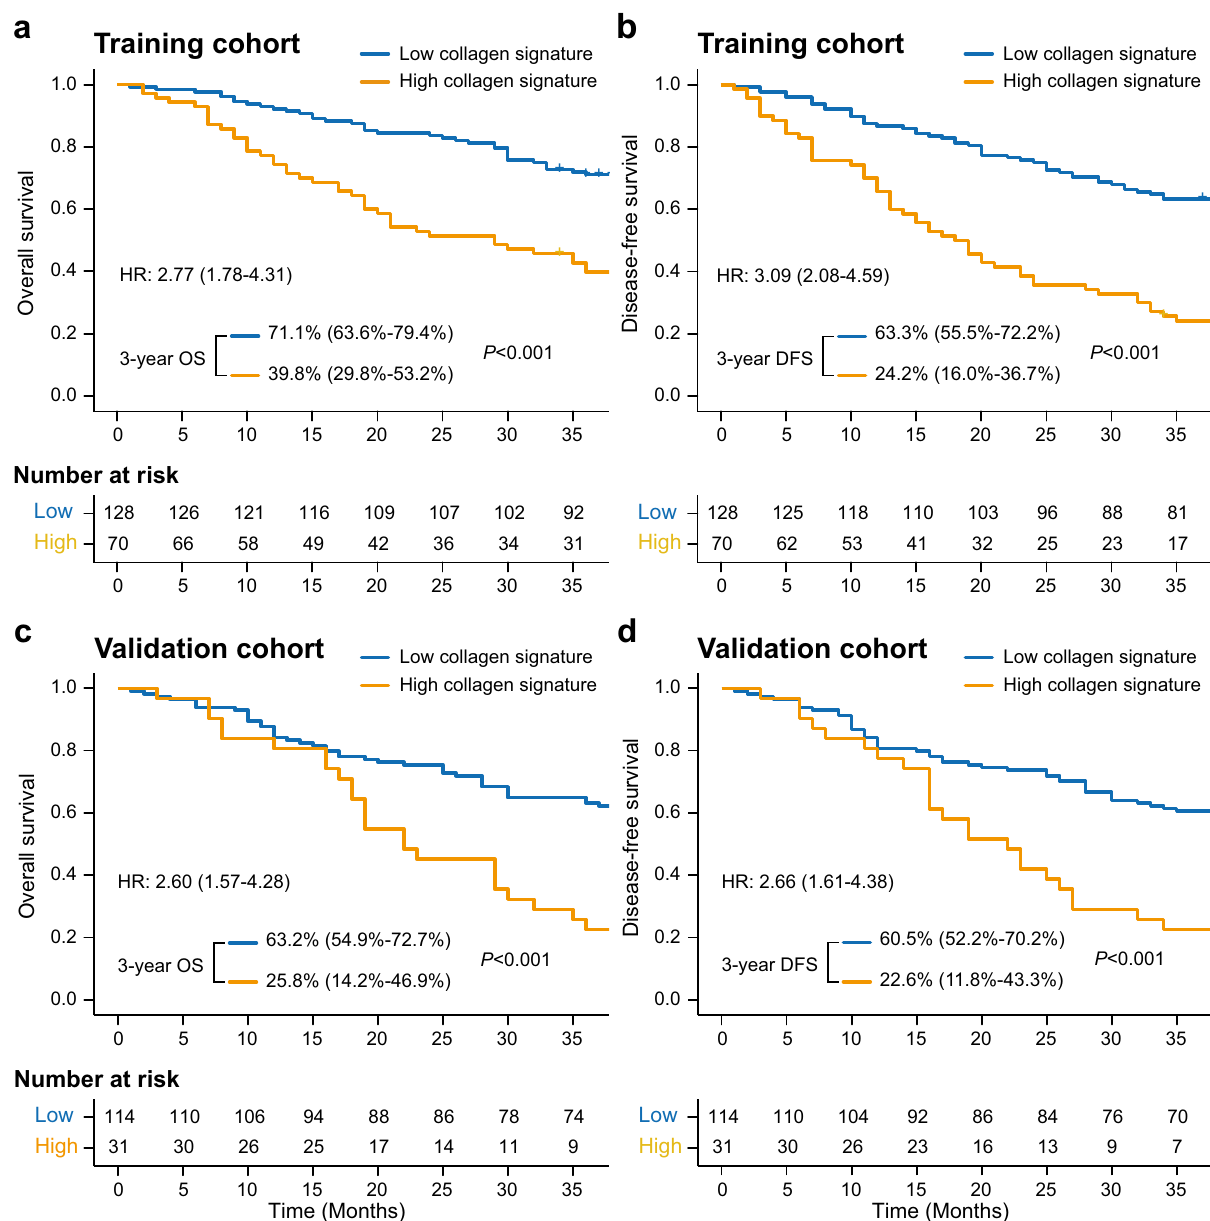
Fig. 3 Kaplan – Meier survival analysis of the training and validation cohorts grouped by the collagen signature. a Three-year OS comparison between the high and low collagen signatures in the training cohort. b The 3-year DFS comparison between the high and low collagen signatures in the training cohort. c The 3-year OS comparison between the high and low collagen signatures in the validation cohort. d The 3-year DFS comparison between the high and low collagen signatures in the validation cohort. The comparisons of OS and DFS between two subgroups are performed using a two-sided log-rank test. OS, overall survival; DFS, disease-free survival; HR, hazard